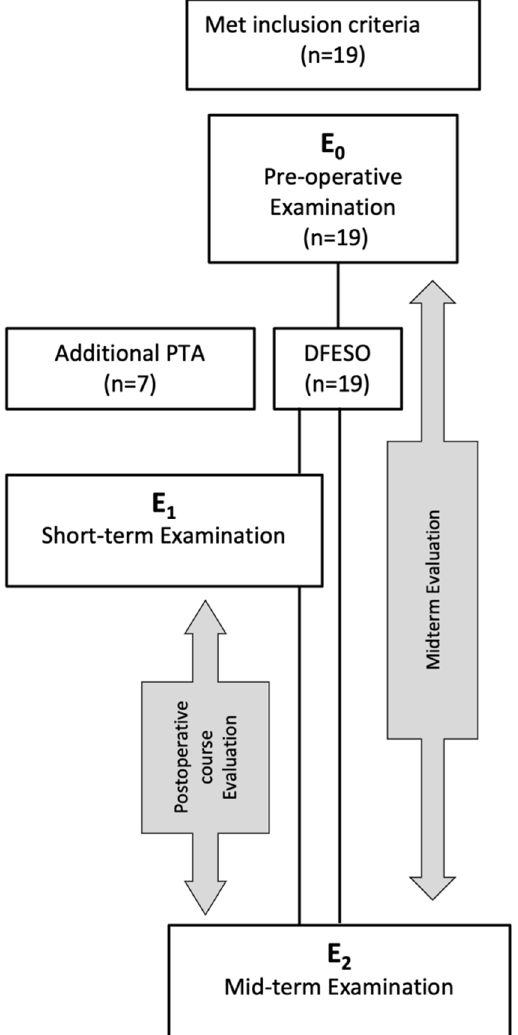
Figure 1. Overview of the different time points of evaluation. E 0 : preoperative, E 1 : short-term examination 6–18 month postoperative; E 2 : mid-term examination 24–60 month postoperative.